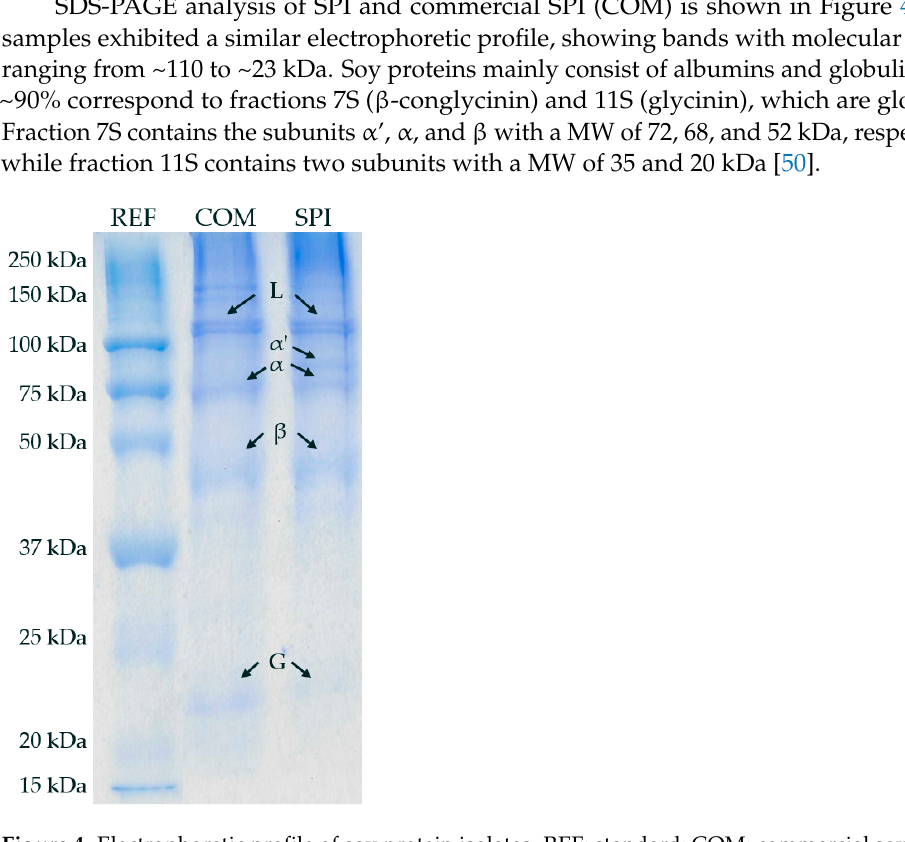
Figure 4. Electrophoretic profile of soy protein isolates. REF: standard; COM: commercial soy protein isolate; SPI: soy protein isolate extracted at optimal conditions (alkaline solution 3, for 45 min and 70 ◦